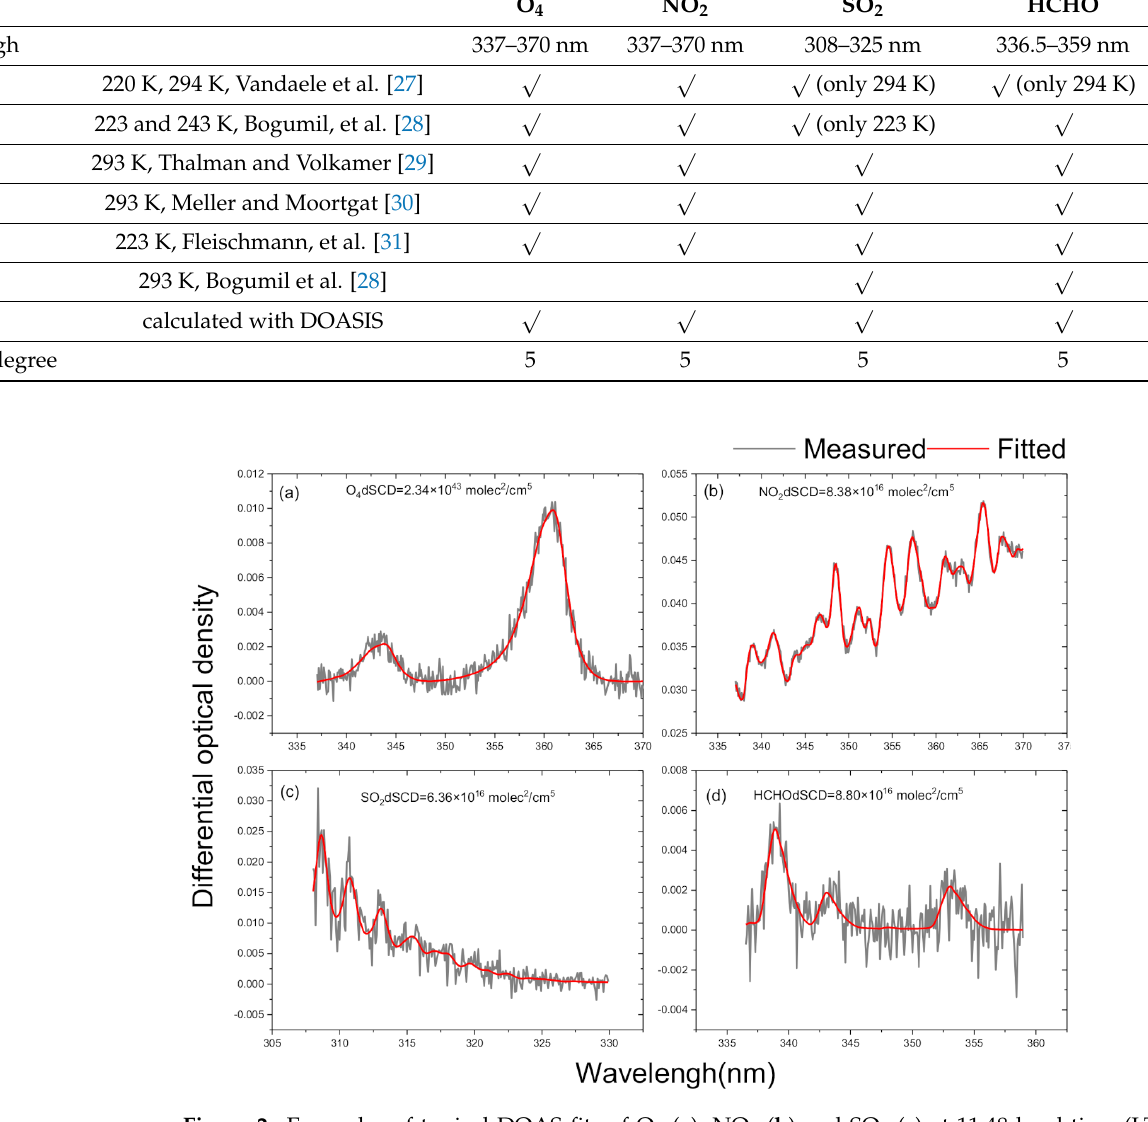
Figure 2. Examples of typical DOAS fits of O 4 ( a ), NO 2 ( b ) and SO 2 ( c ) at 11:48 local time (LT) on 11 December 2019 as well as HCHO ( d ) at 11:03 LT on 21 July 2019 at Qingdao station. The fitted differential slanted column densities (dSCDs) of NO 2 , O 4 , SO 2 , and HCHO are given in the corresponding subfigures. The black and red curves indicate the fitted absorption structures and the derived absorption structures from the measured spectra,